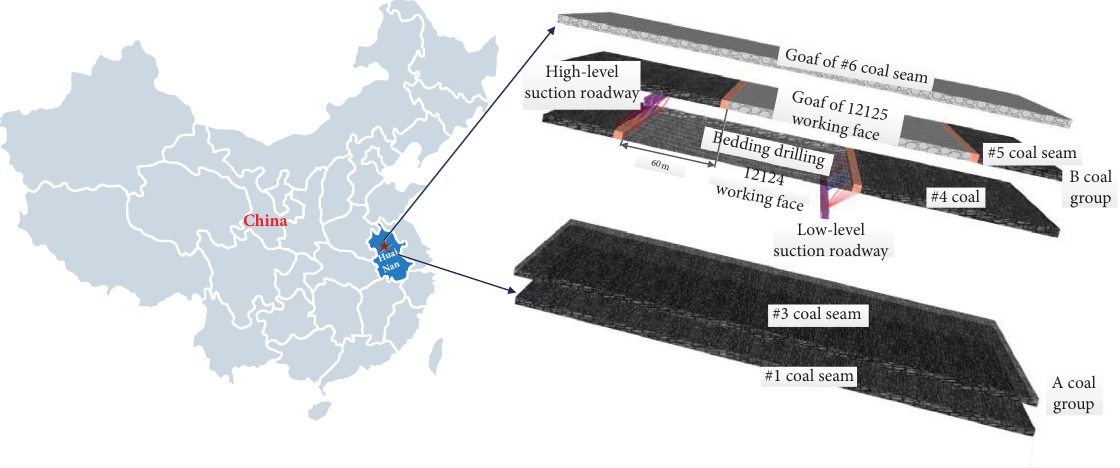
Figure 1: The 12124 working face mining